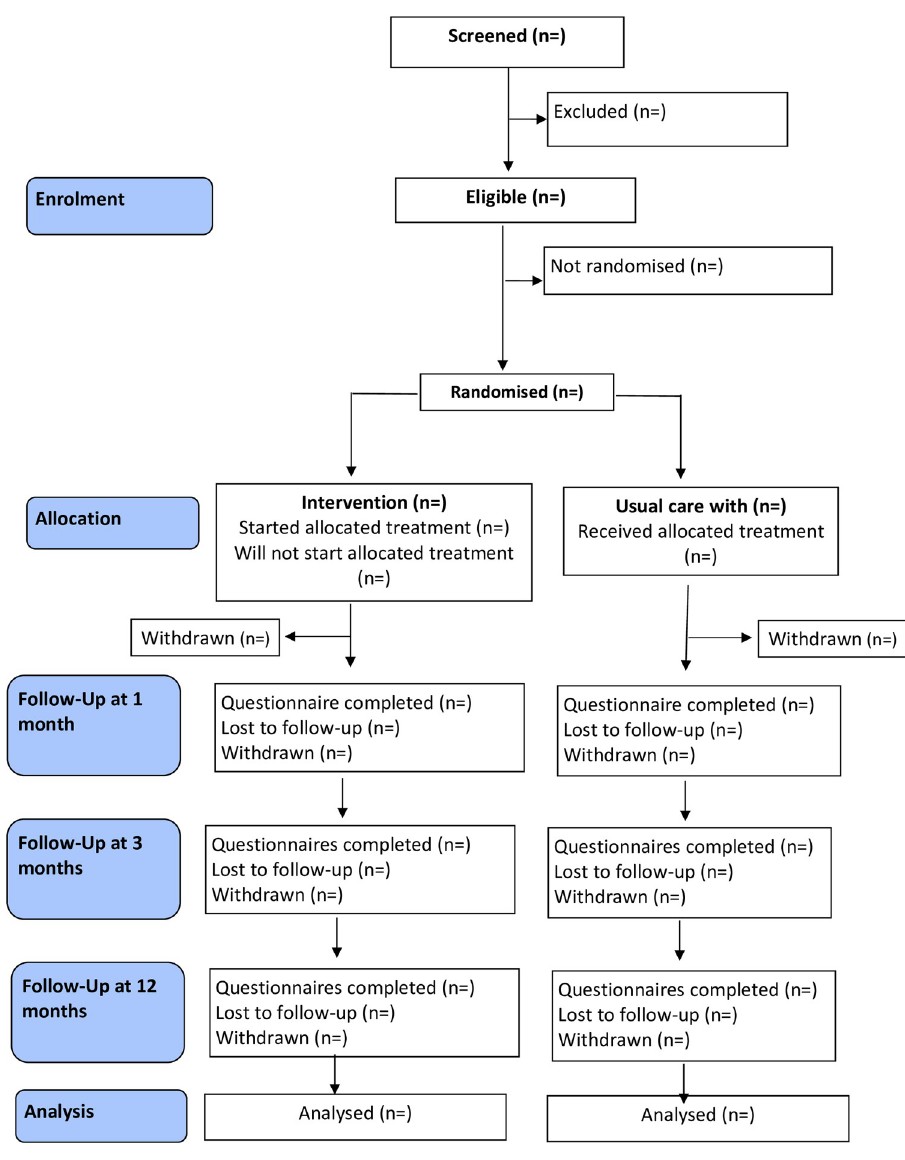
Fig 2. BASIL+ CONSORT flow